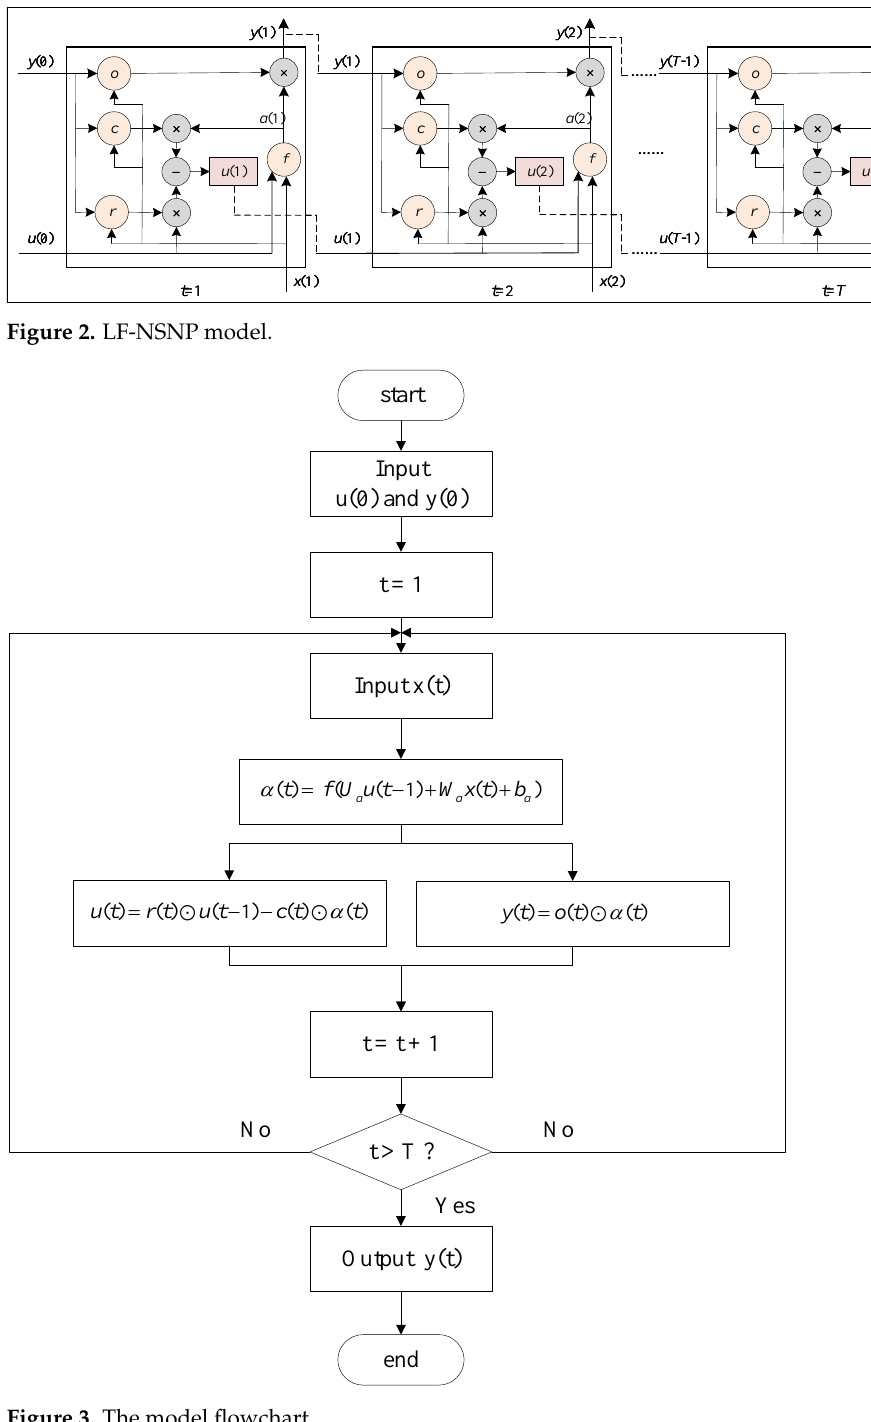
Figure 3. The model